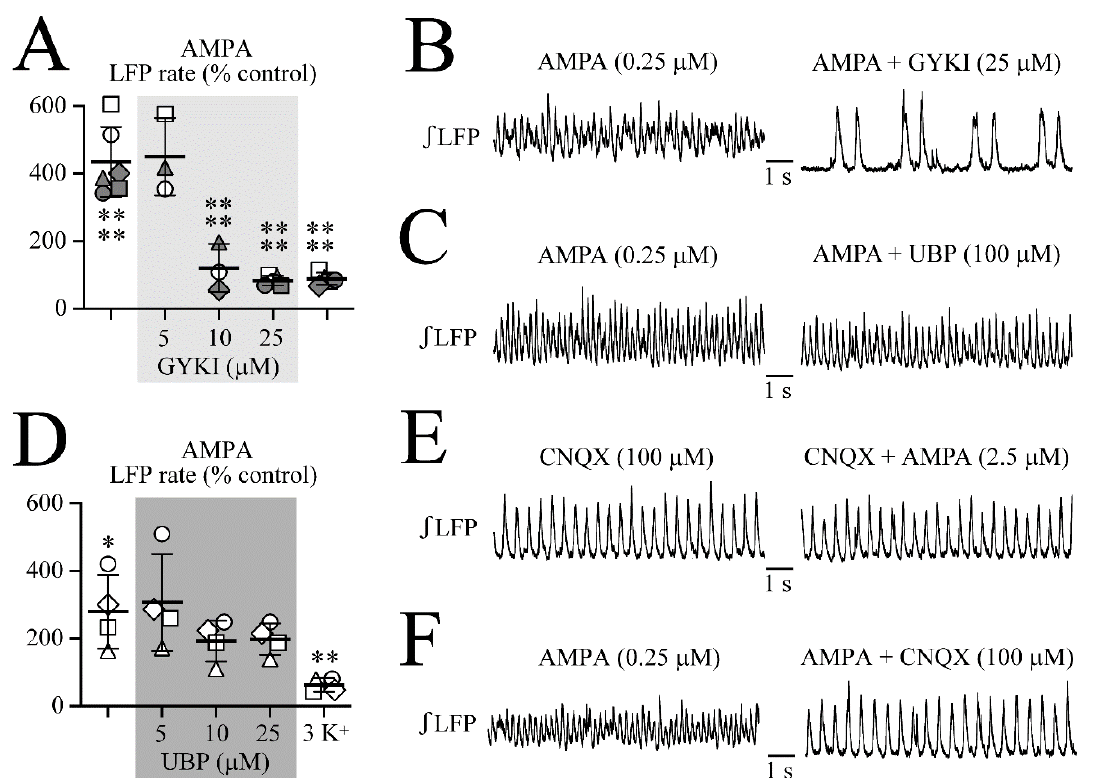
Figure 10. Effects of iGluR blockers on AMPA-evoked LFP oscillations. ( A , B ) The LFP oscillations due to either 0.25 or 0.5 µ M AMPA were 435% faster than the control rhythm (Each slice is represented by the same symbol). The addition of 5 µ M of the selective AMPAR blocker GYKI-53655 did not counter the AMPA-evoked oscillations in contrast to both 10 µ M and 25 µ M. ( C , D ) The AMPA- induced LFP oscillations were not countered by 5, 10, or 25 µ M of the selective KAR blocker UBP-302. ( E ) CNQX modestly accelerated the LFP rhythm compared to the control (not shown) but suppressed the spindle-shaped faster oscillations that were typically evoked by AMPA. ( F ) The ‘classical’ AMPAR blocker 6-cyano-7-nitroquinoxaline-2,3-dione (CNQX) acting as partial AMPAR agonist on newborn rat LC neurons [27] blocked the AMPA-evoked LFP oscillations. Significances (* p < 0.05, ** p < 0.01, **** p < 0.0001) in ( A , D ) was obtained with one-way ANOVA with Dunnett’s